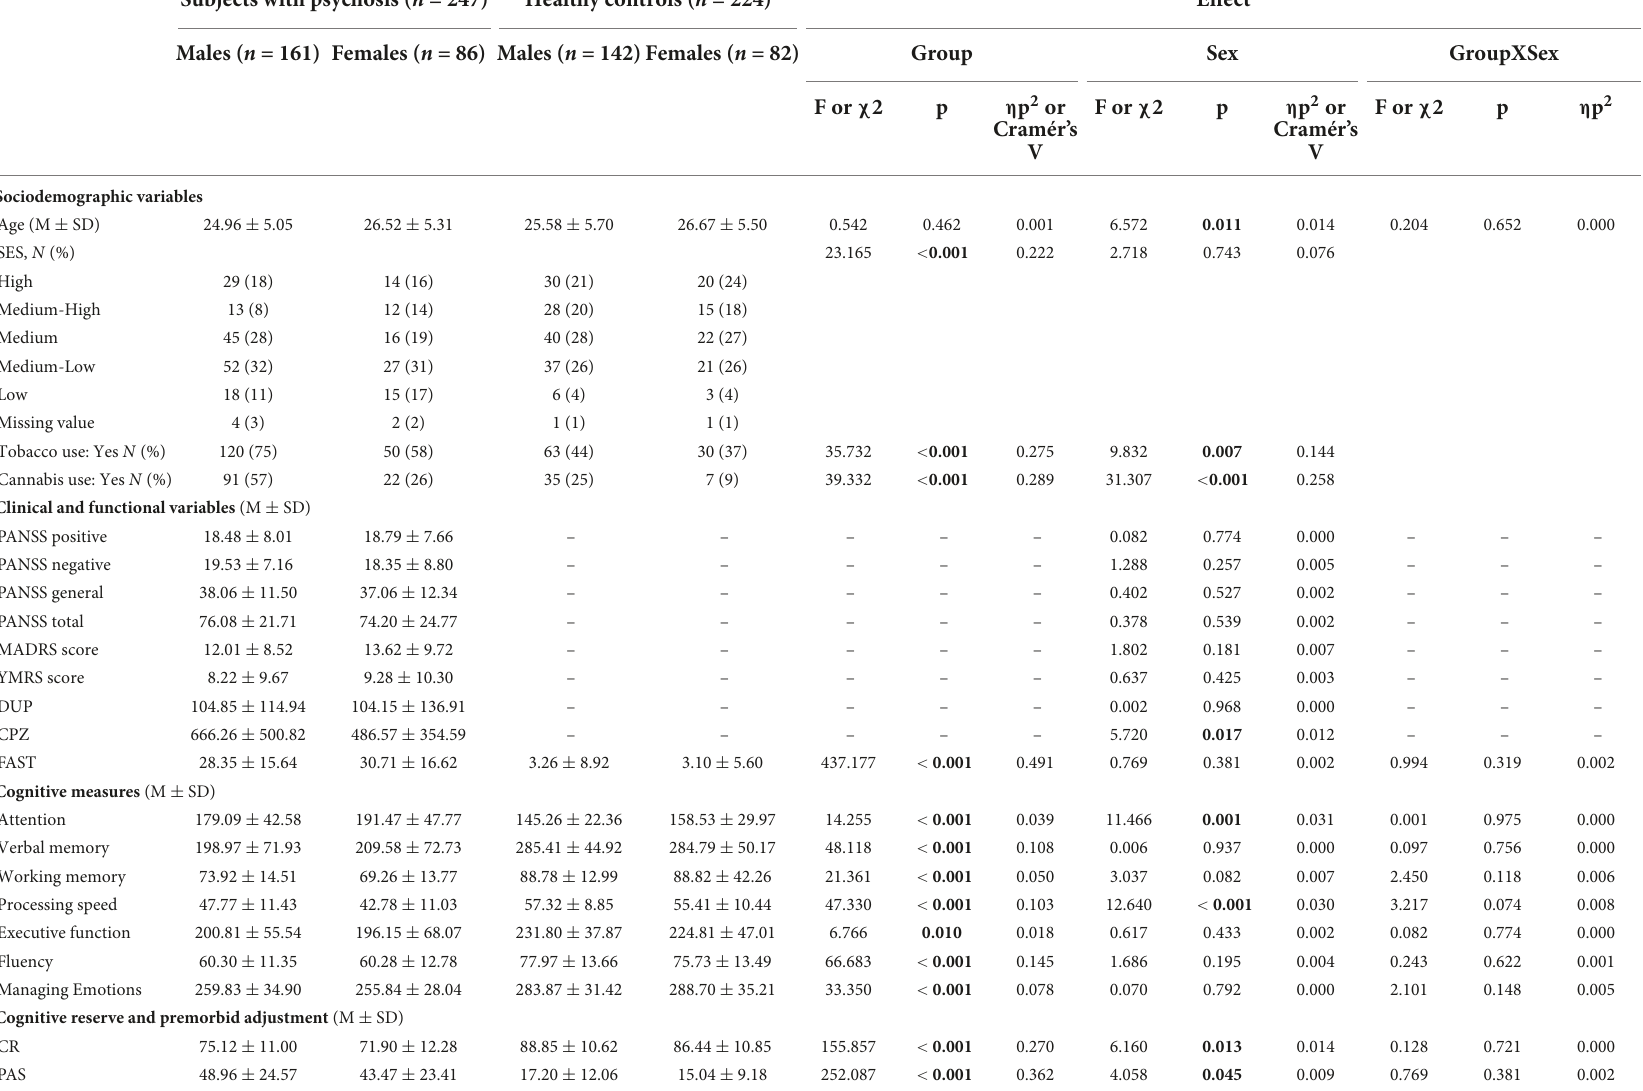
TABLE 1 Sex differences in sociodemographic, clinical and functional characteristics at baseline for subjects with psychosis and healthy controls. Subjects with psychosis ( n = 247) Healthy controls ( n = 224)